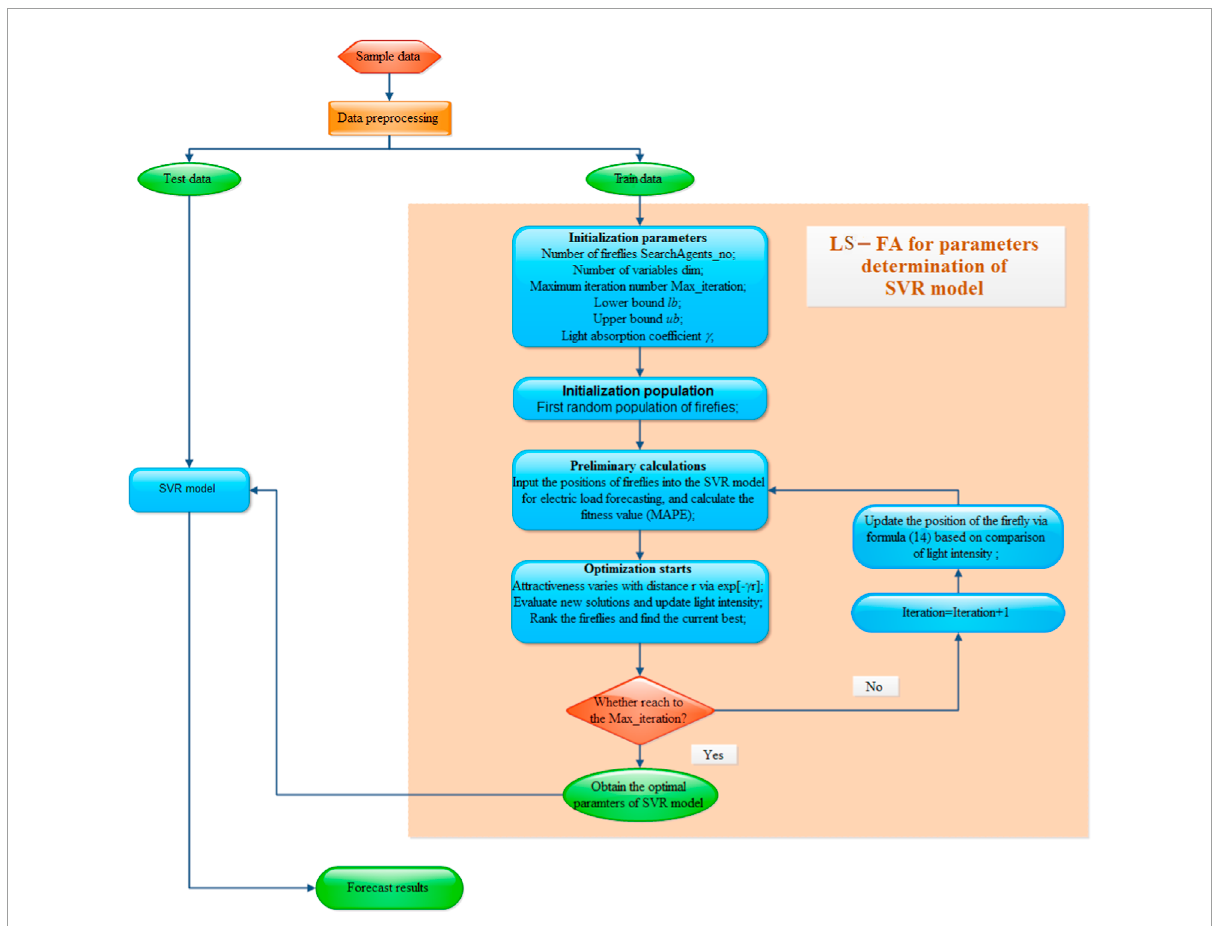
FIGURE 4 Flow of the LS-FA-SVR model for electric load